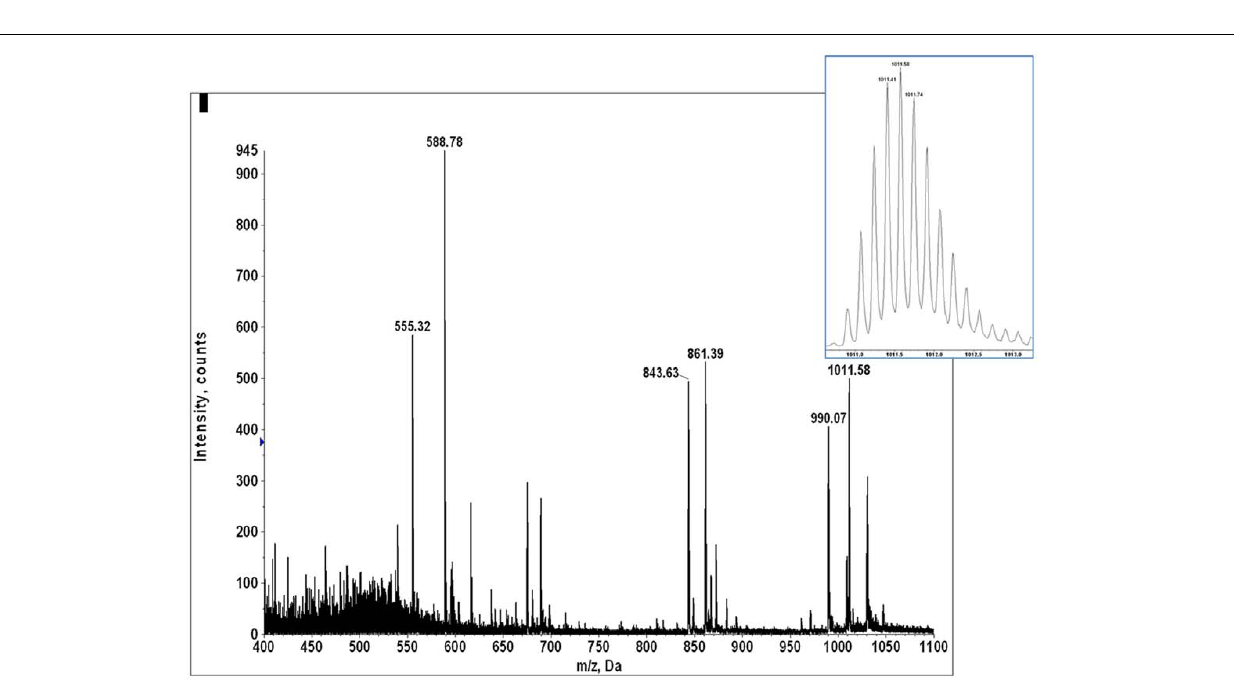
Frontiers in Immunology |T Cell Biology December 2011 |Volume 2 | Article 75 |